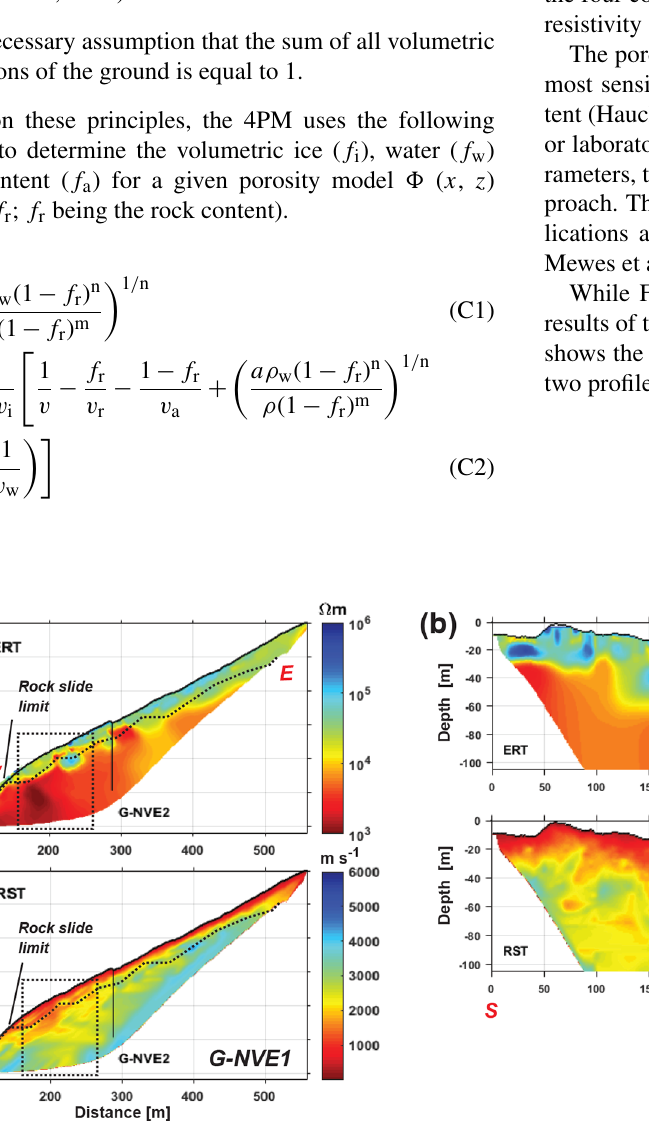
Figure C1. Resistivity and seismic velocities for the 4PM at Gámanjunni-3 for (a) G-NVE1 and (b) G-NVE2. Note that the profiles are subsets of G-NVE1 and G-NVE2 and are thus shorter than shown in Figs. 8 and B1. Note also that the colours for the electrical resistivity do no correspond to the colour scale derived from the laboratory analysis (Fig. 3) but are the original results first presented in Hauck and Hilbich (2018). The possible fracture zones mentioned in the paper are indicated as a box, while the possible lower permafrost limit is drawn as a line in (a)